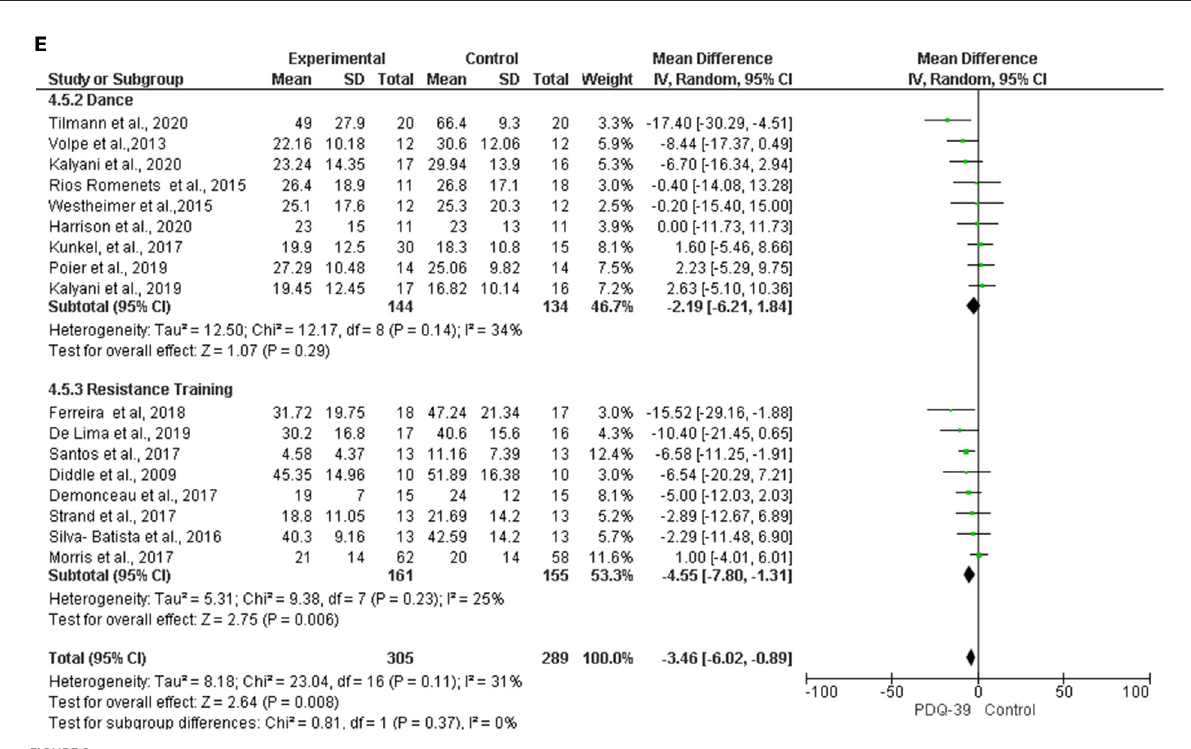
FIGURE2 (A) Subgroup analysis of rhythmic cueing, dance and RT of Gait Velocity. (B) Subgroup analysis of rhythmic cueing, dance, and RT of stride length. (C) Subgroup analysis of rhythmic cueing, dance, and RT of functional mobility - TUG. (D) Subgroup analysis of rhythmic cueing, dance, and RT of motor symptoms - UPDRS-III. (E) Subgroup analysis of dance and RT of